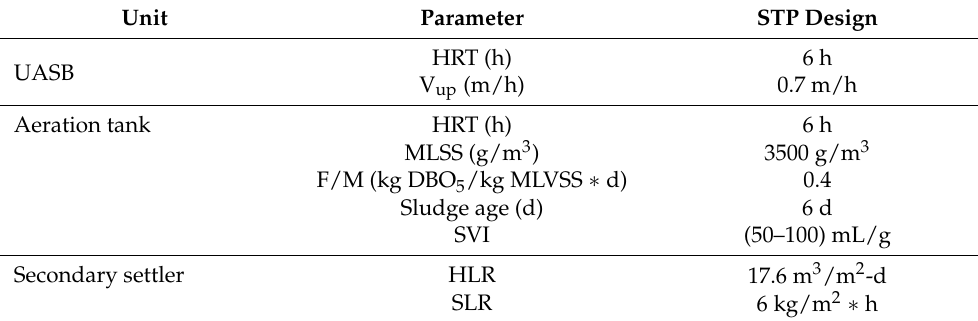
Table 1. Design values adopted for the Tunja STP.